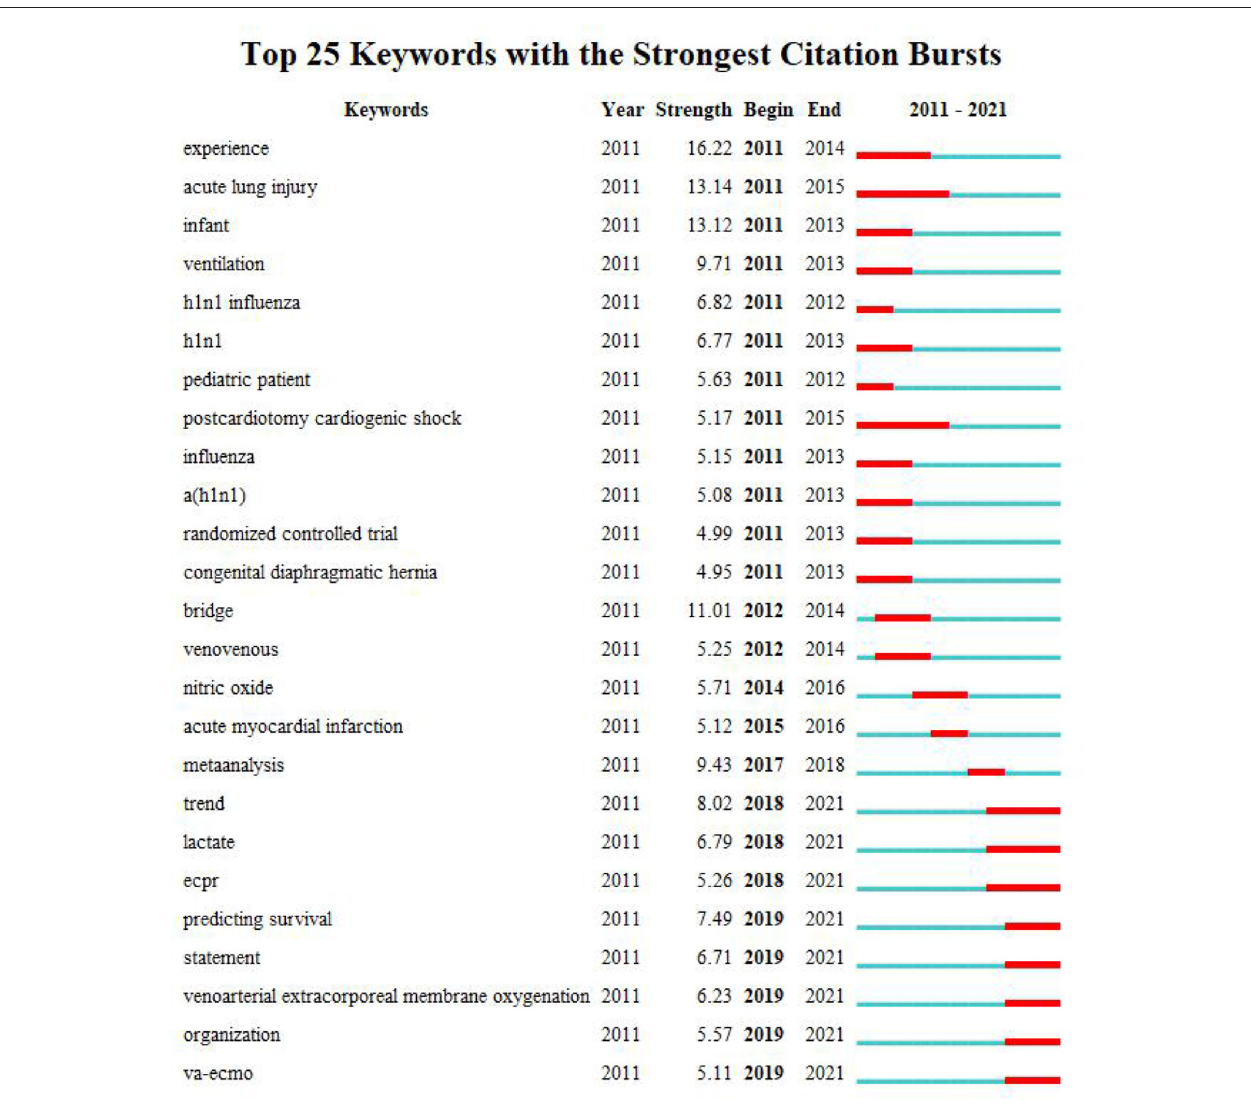
FIGURE 7 | Burst test of